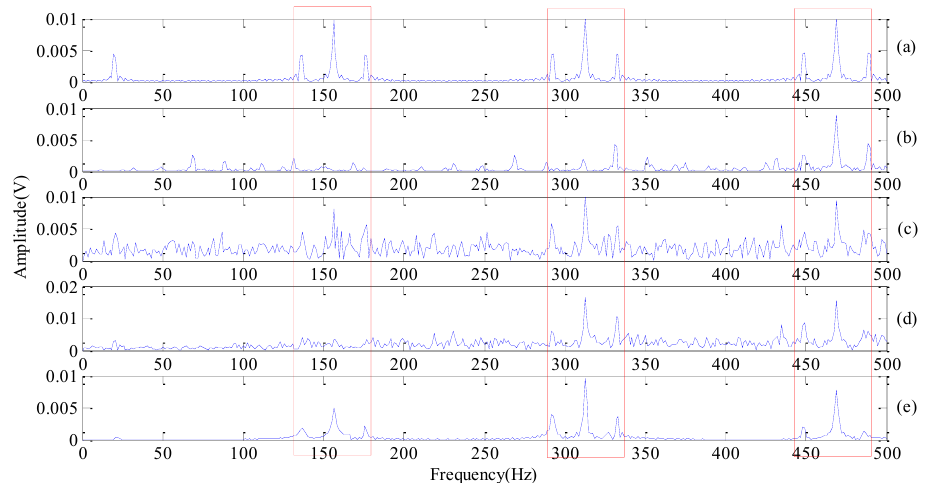
Figure 5. Frequency spectrum with different methods ( a ) FFT of noise-free signal; ( b ) SVD; ( c ) WT; ( d )